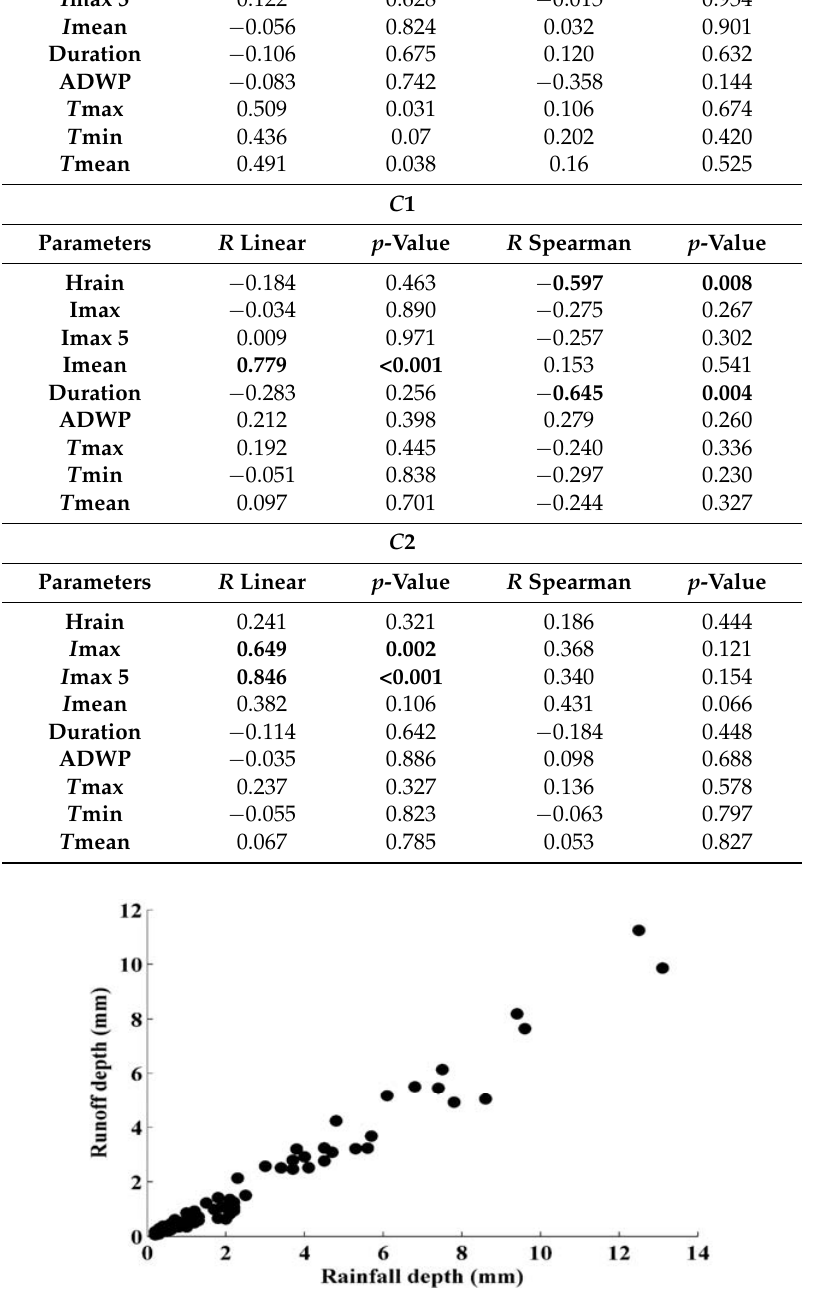
Figure A1. Variation of runoff depth in function of rainfall depth for 106 events.